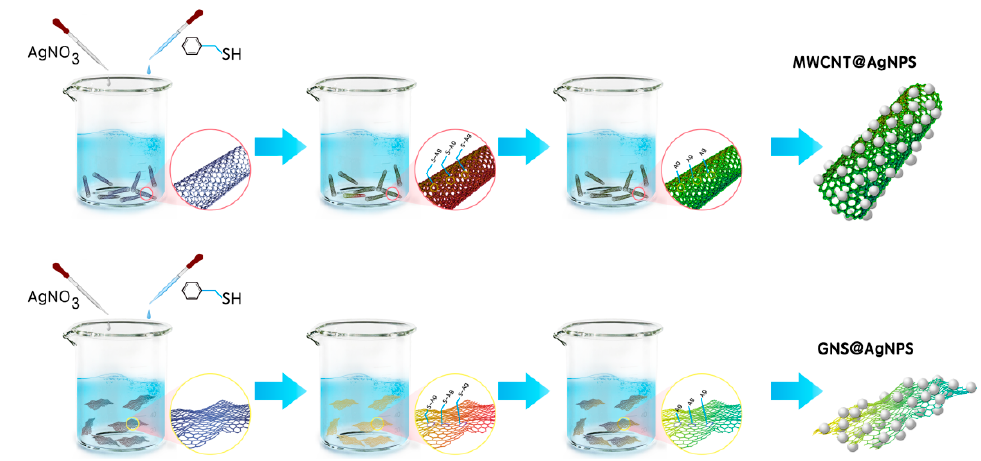
Figure 1. Schematic diagram illustrating the preparation of a coated structure of MWCNT@AgNPs and